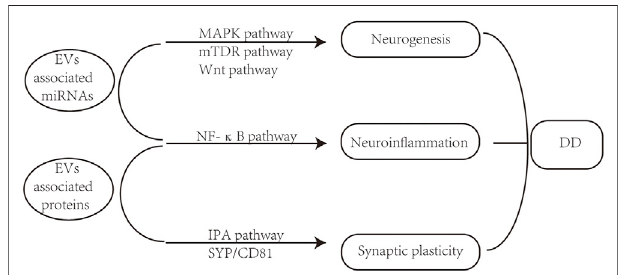
FIGURE 2 | EVs associated pathogenic changes in DD. EV associated microRNAs and proteins can regulate neurogenesis, neuroin fl ammation, and synaptic plasticity in the development of DD.